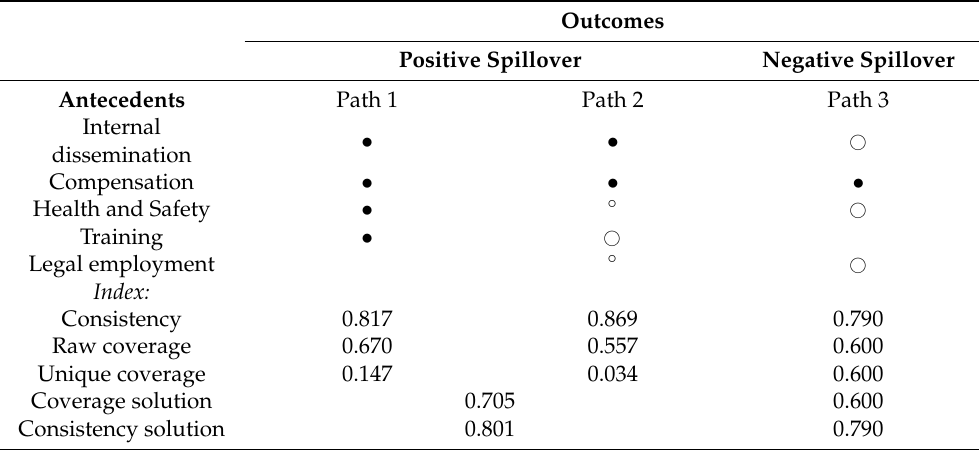
Table 3. Configurations for positive and negative work to family